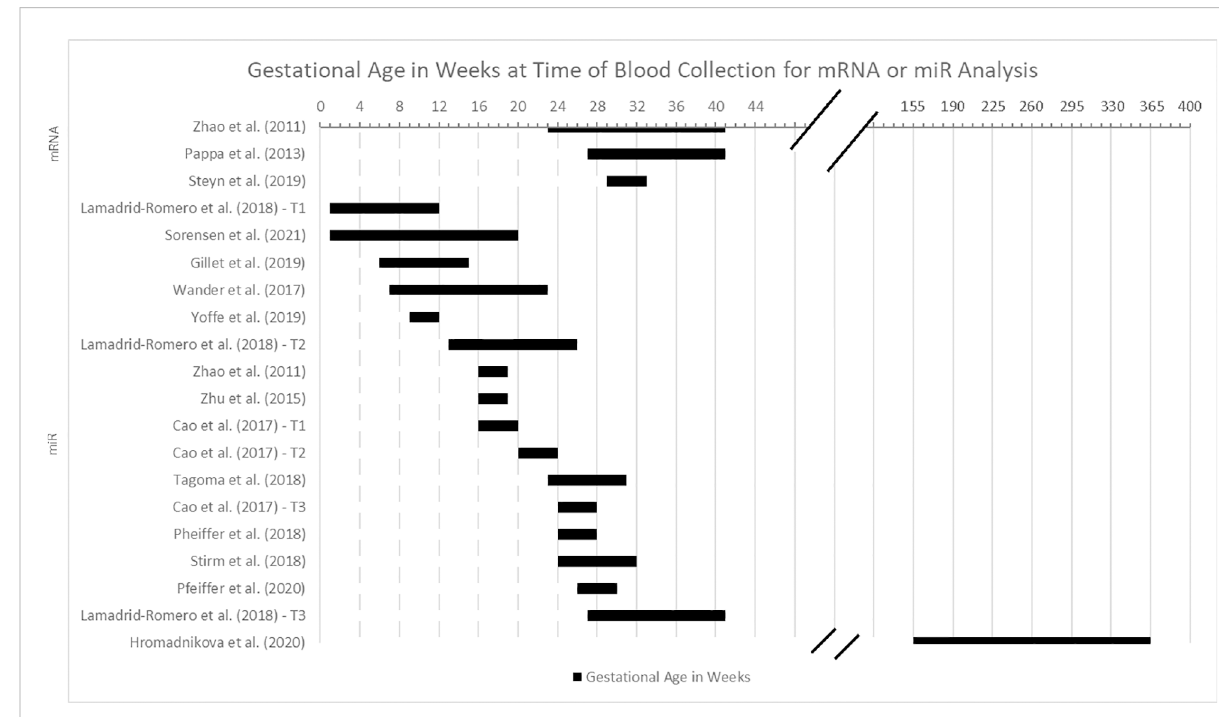
FIGURE 2 Gestational age in weeks at time of blood collection for miRNA or mRNA